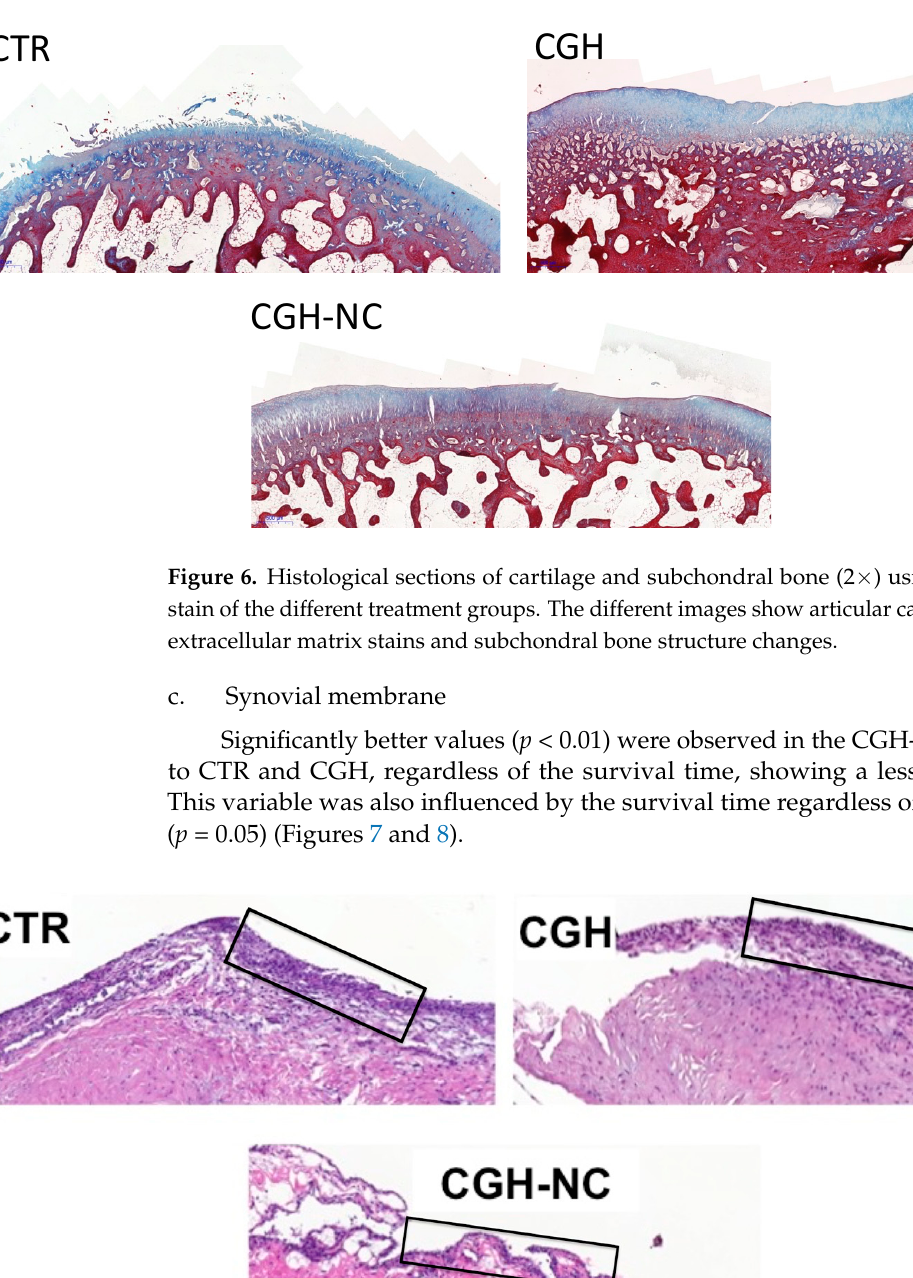
Figure 5. Heat map representing “subchondral bone” changes in the different treatment groups at different survival times and the frequency of occurrence at different survival times. Clearer colours result in an increase of the frequency of each stage of the disease. Orange lines are included on the maps to facilitate the understanding of the behavior of each treatment and the survival time. A sta- tistically significant change occurred in all groups regardless of the treatment ( p < 0.05).